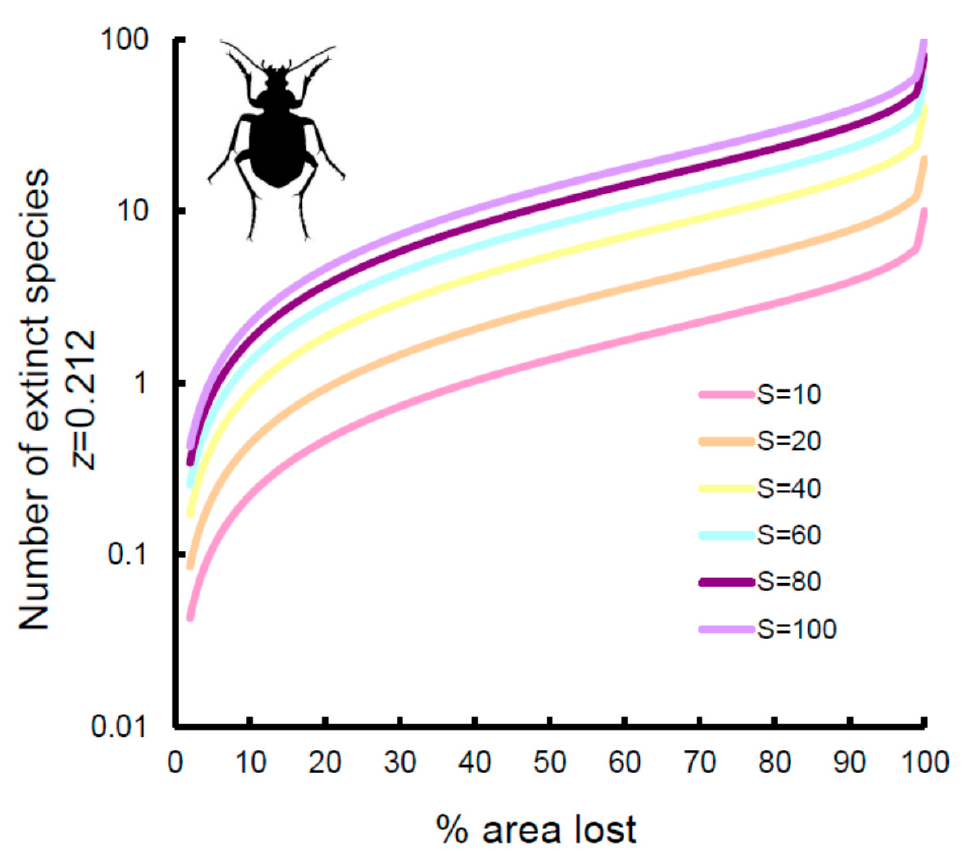
Figure 4. Number of extinct species expected on the basis of area loss (% of area lost) for the Carabidae of Italian reserves for areas hypothetically hosting 10, 20, 40, 60, 80, and 100 species. Curves were calculated using z = 0.212, as obtained from the power function of the species–area relationship. Use of z -values from multiple models did not change the pattern. Note the log-scale for the y -axis.